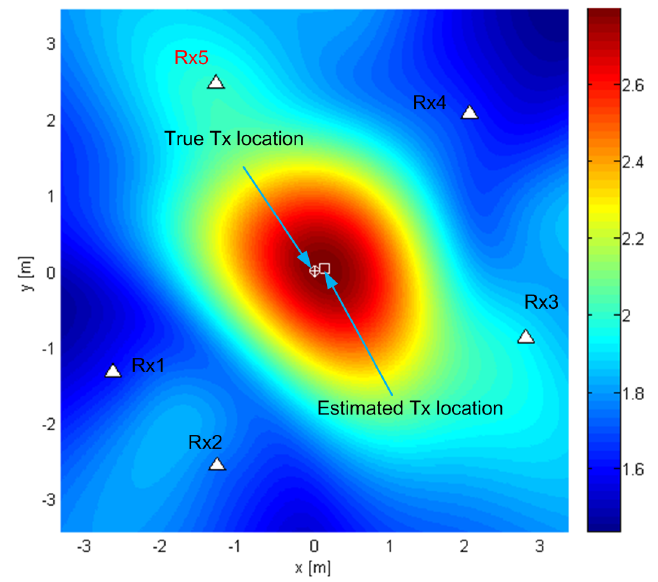
Figure 2. The criterion function for G 5 and T 1 for the MCME algorithm.